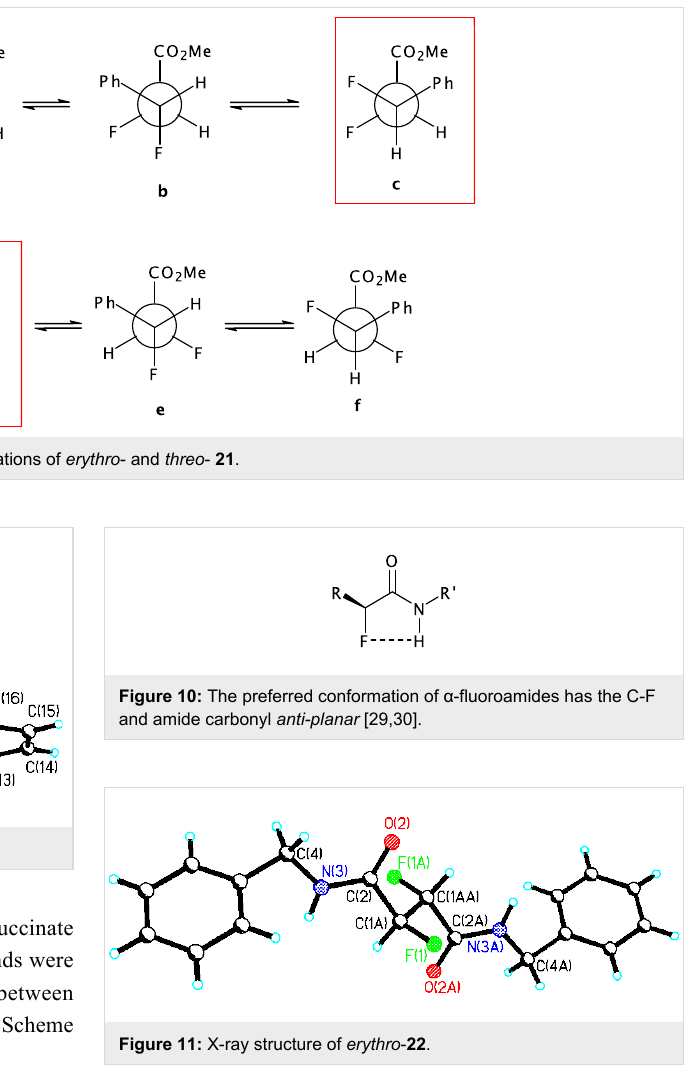
directions. The α-fluoroamide groups tend towards a syn -planar C-F...N-H conformation as it is typical for this functional group (Figure 10) with the C-F bonds only 23° off the plane. The carbonyls point in opposite directions and thus intramolecular hydrogen bonding is not possible. There is however strong intermolecular hydrogen bonding between the amide hydrogen and the carbonyl oxygen of adjacent molecules which is domin- ating the unit cell structure (Figure